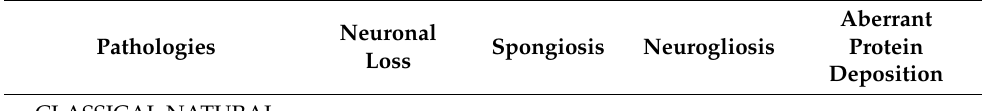
Table 2. Main neuropathological characteristics described in the cerebellar cortex in natural scrapie in comparison with other regions of the brain in this disease and also in other prion diseases (atypical scrapie and human prionopathies), as well as in Alzheimer’s disease